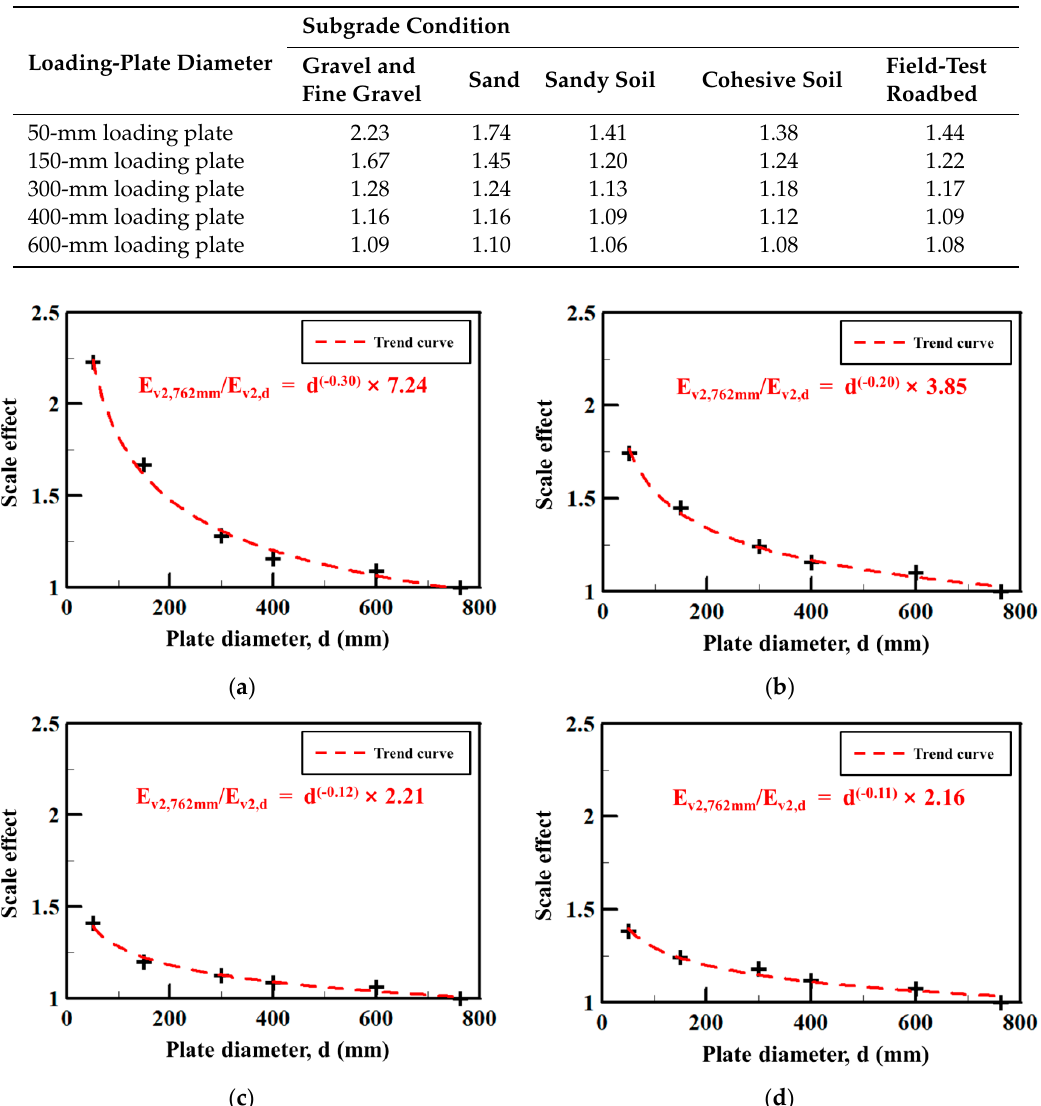
Table 6. Scale e ff ect of repetitive plate-loading test according to the subgrade condition. Table 6. Scale effect of repetitive plate-loading test according to the subgrade condition.